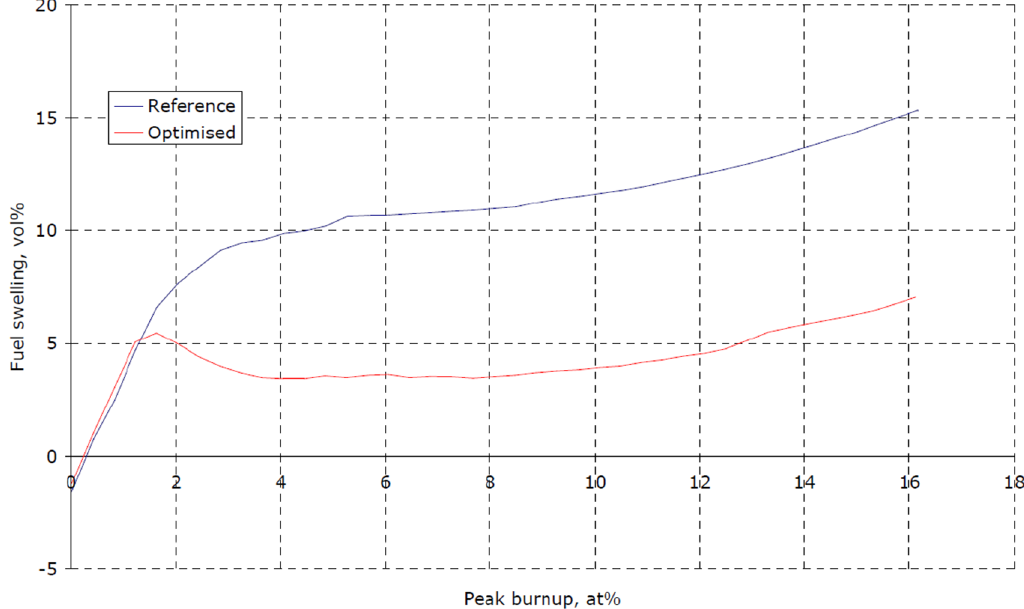
Fig. 1. Fuel swelling (level 4) for the optimized and reference carbide fuel pin